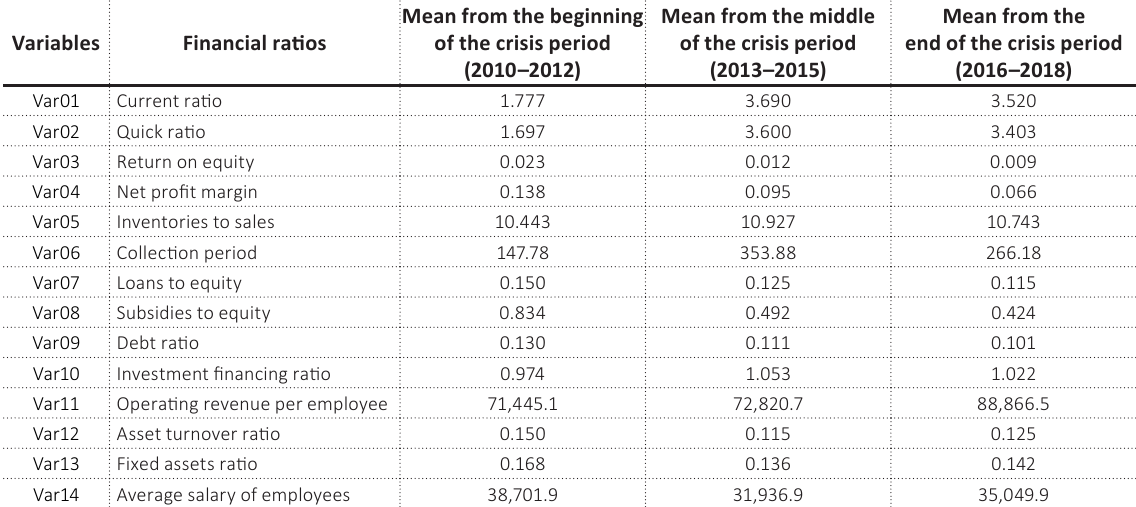
Table 4. Comparison of financial ratios in the economic crisis